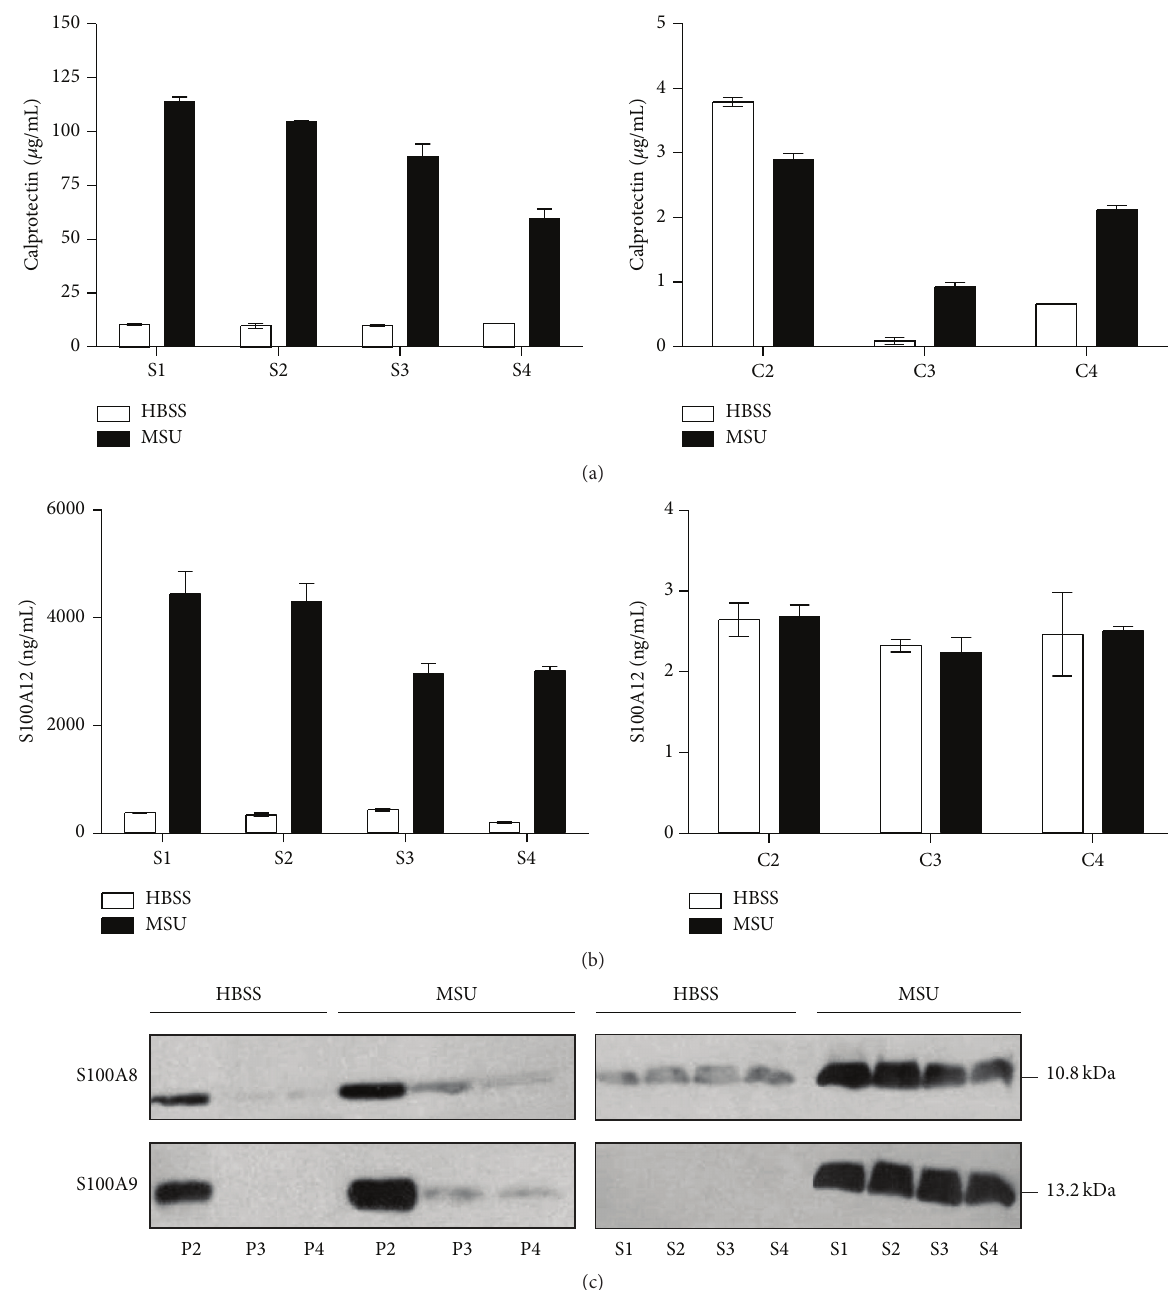
Figure 8: S100A8/A9 and S100A12 are almost absent from microvesicles. Neutrophils were incubated with MSU crystals (1.5mg/mL) or its diluent for 60min at 37 ∘ C. The MV were isolated after sequential centrifugation. The concentrations of (a) S100A8/A9 and (b) S100A12 were determined by ELISA in the supernatant fractions (S1, S2, S3, and S4) and the pellet fractions (P1, P2, and P3) containing the MV. Data are the mean ± SEM of three separate experiments. (c) The presence of S100A8 and S100A9 in the supernatants and MV was determined by western blot. Results are from one experiment representative of 2